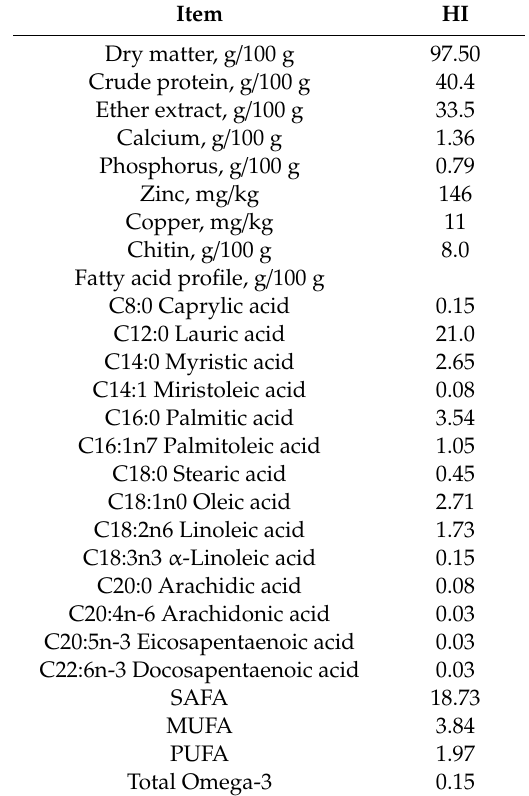
Table 1. Analysis of the chemical composition of full-fat Hermetia illucens meal (HI). Item HI Dry matter, g / 100 g 97.50 Crude protein, g / 100 g 40.4 Ether extract, g / 100 g 33.5 Calcium, g / 100 g 1.36 Phosphorus, g / 100 g 0.79 Zinc, mg / kg 146 Copper, mg / kg 11 Chitin, g / 100 g